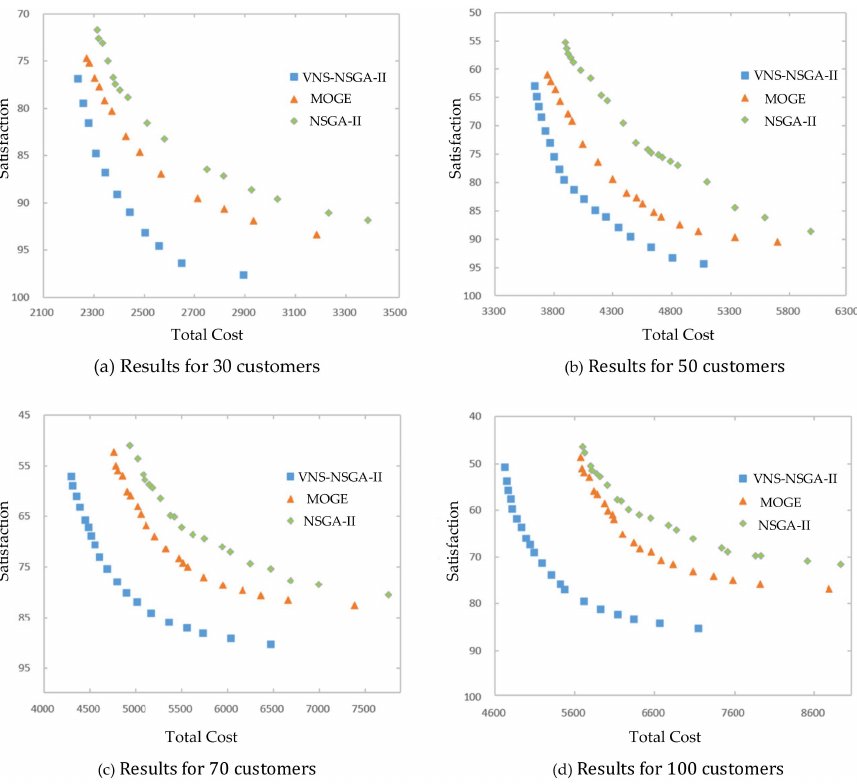
Figure 6. Pareto-optimal front comparison of different customer sizes.